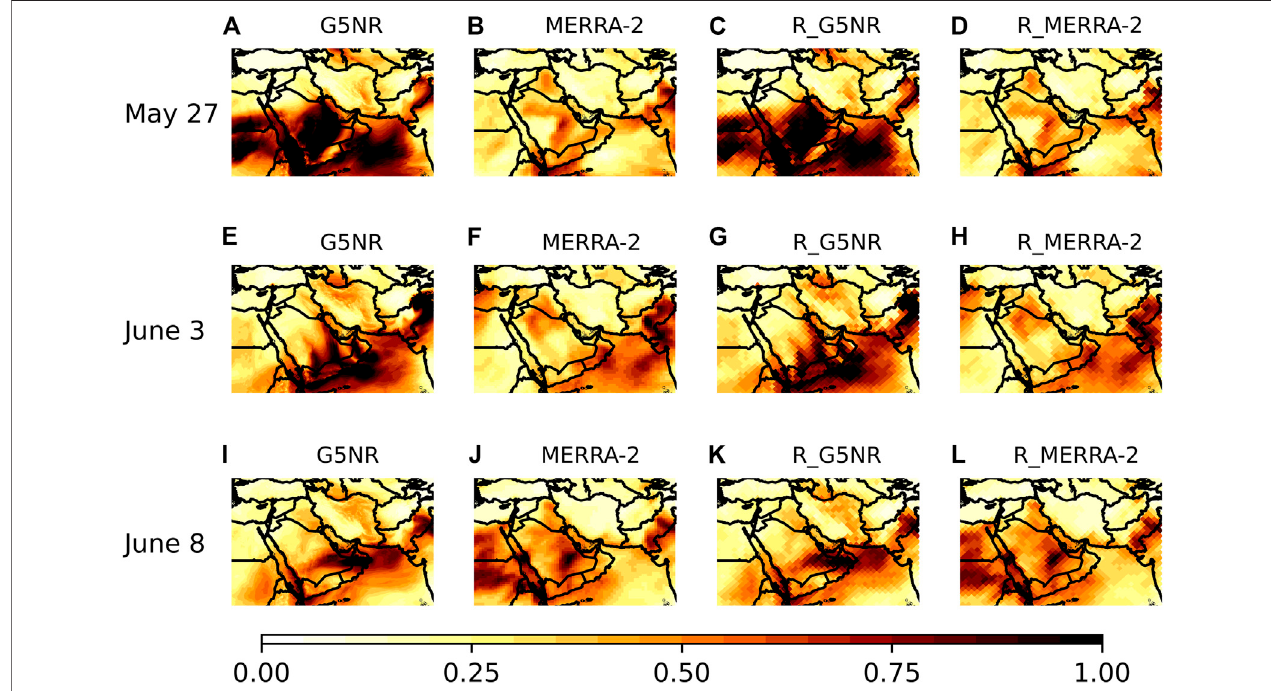
FIGURE 1 | (Top) Daily mean AOD from (A) G5NR and (B) MERRA-2 on May 27th, 2006. (C) and (D) are remapped (A) and (B) into lower-resolution pixels with 102 km grid spacing. (Middle) (E) – (H) are same as (A) – (D) , but for June 3rd, 2006. (Bottom) (I) – (L) are same as (A) – (D) but for June 8th, 2006.